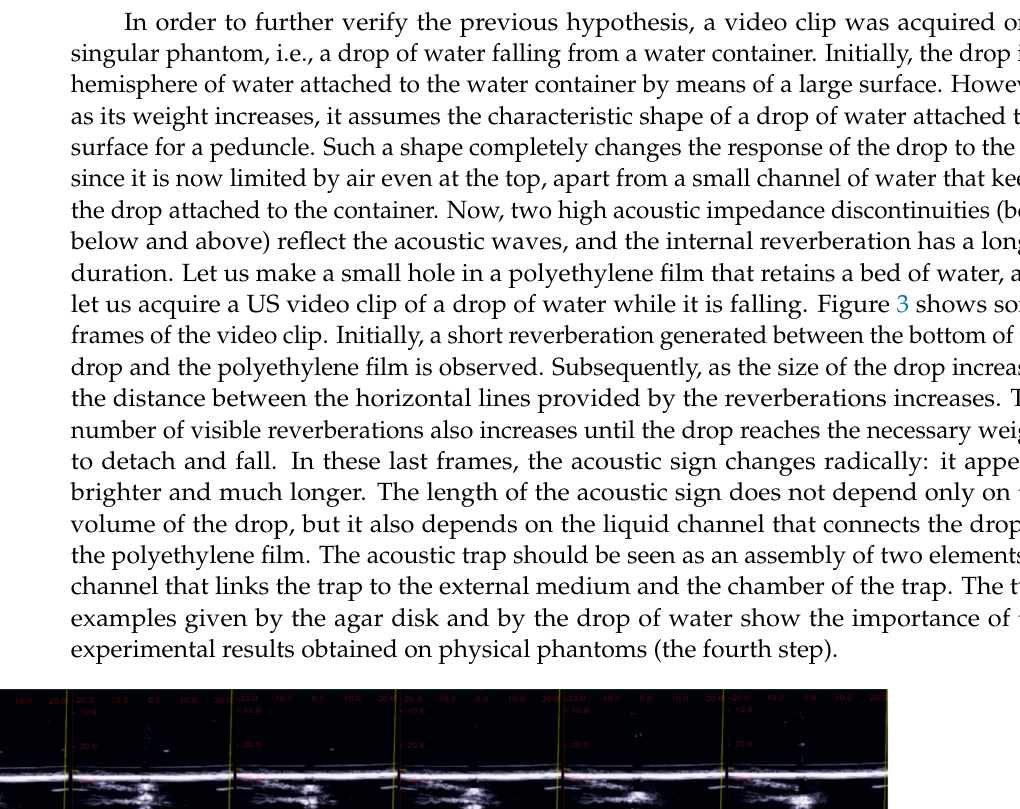
Figure 2. ( a ) Shows an agar disk positioned between two polyethylene films with the upper film that rests only on the central part of the agar disk. ( b ) Shows how the agar disk generates a short reverberation in the center and longer reverberations on the periphery where the agar is partially limited by air even at its upper wall.